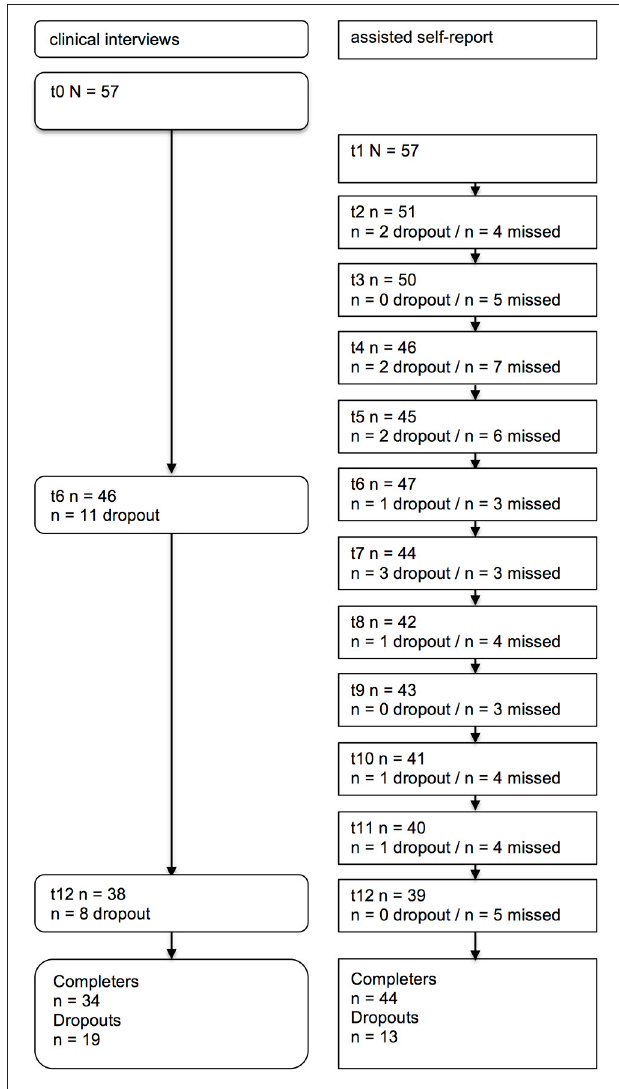
FIGURE 1 | Flow of participants through the study. Clinical interviews = half-yearly semi-structured clinical interviews, assisted self-report = monthly assisted self-report on the telephone, dropout = participants dropping out of the study at the specific time point, missed = participants who missed an interview at the specific time point but who continued their